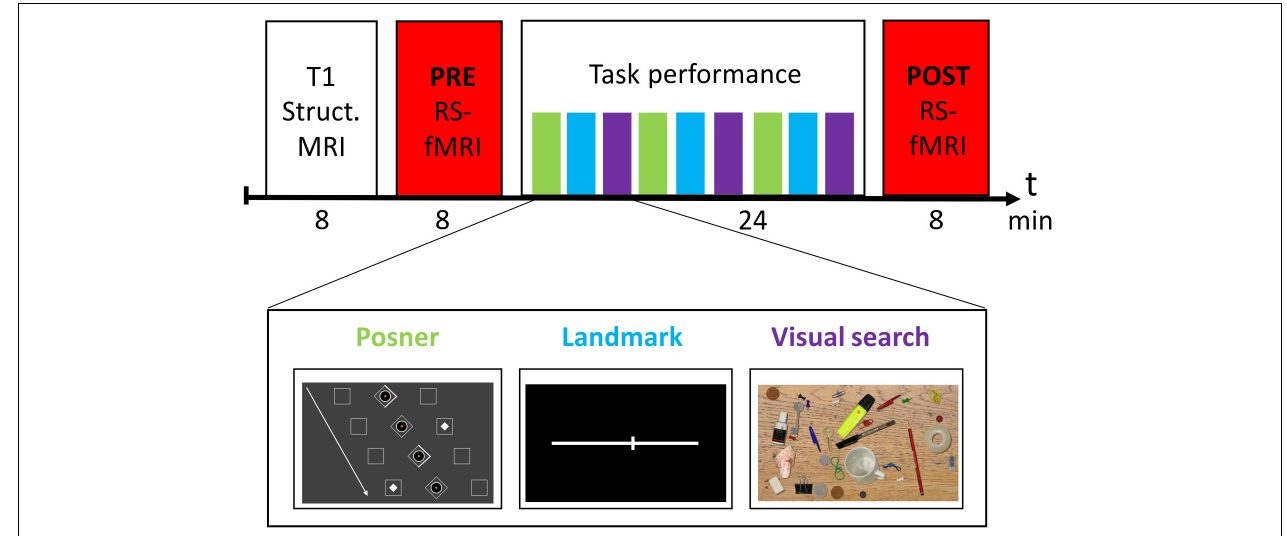
FIGURE 1 | Experimental